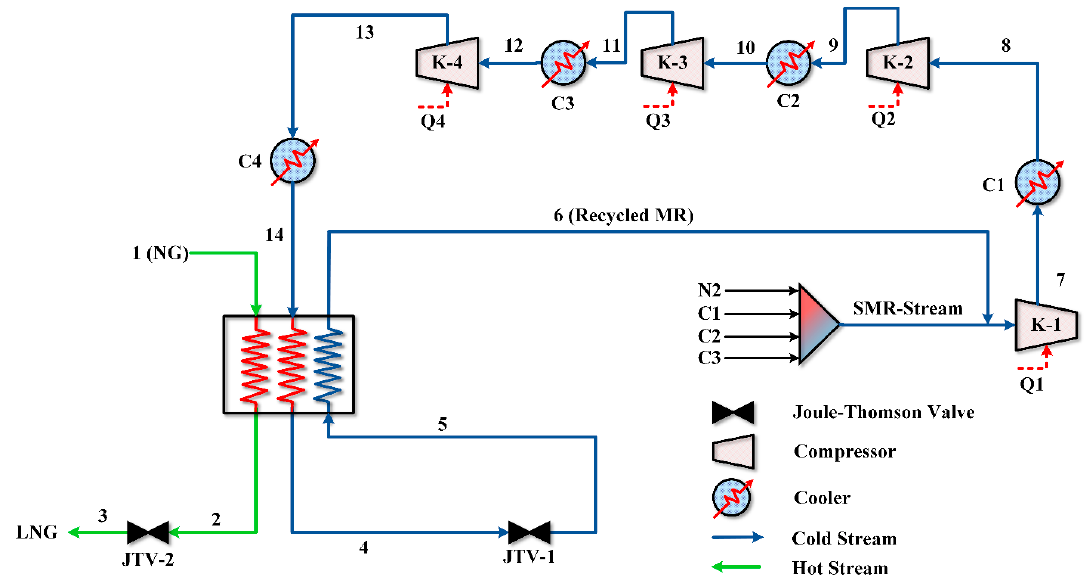
Figure 4. Process flow diagram of the single mixed refrigerant (SMR) process.